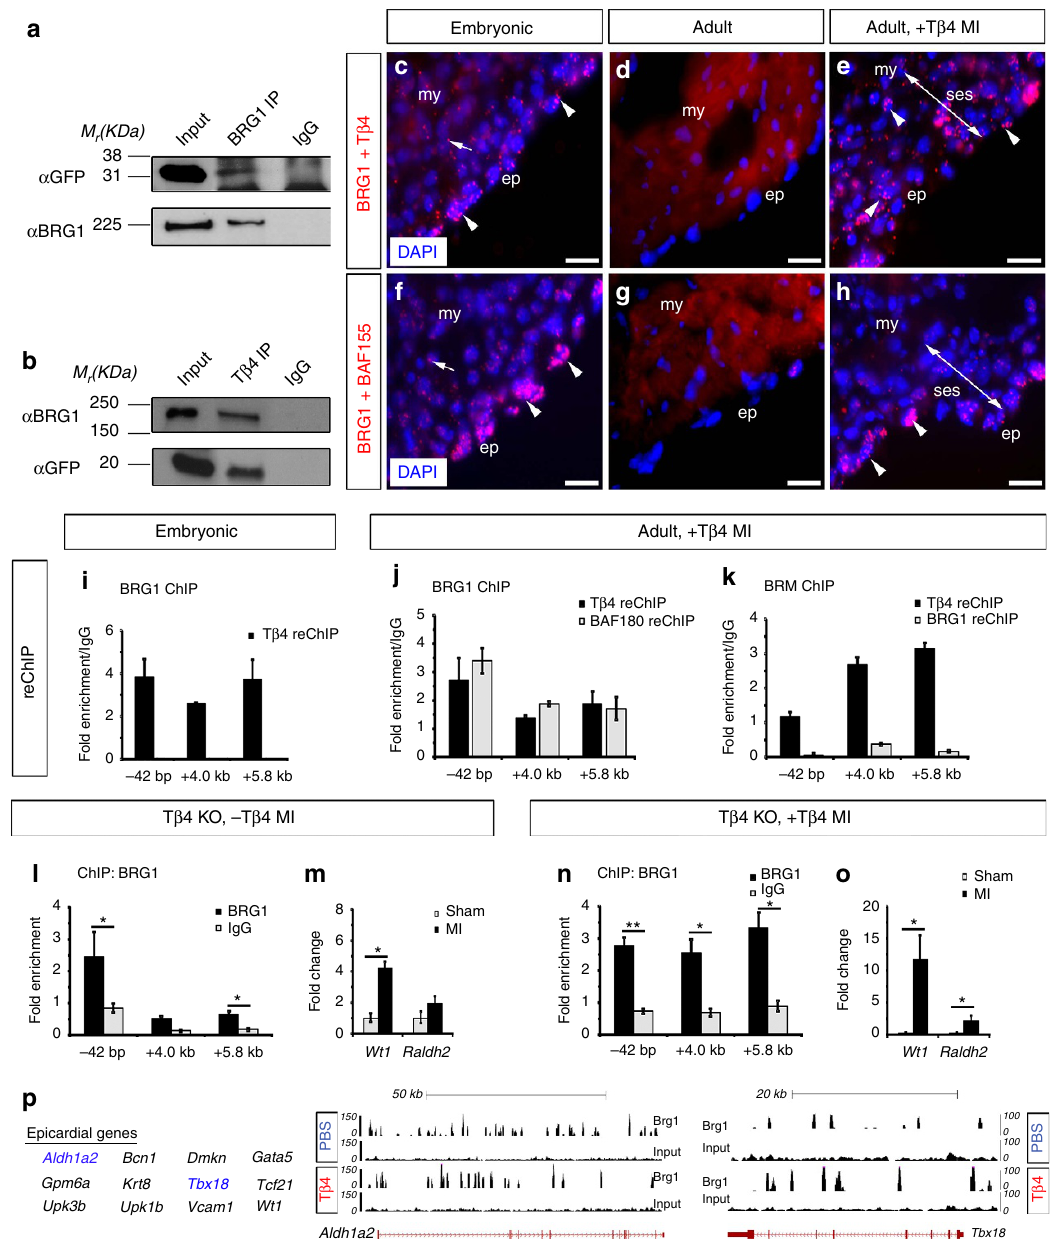
Figure 4 | T b 4 interacts with SWI/SNF enhancing activation of the adult epicardium. ( a , b ) Immunoprecipitation experiments with T b 4-EGFP- transfected cells using anti-BRG1 ( a ) or anti-T b 4 ( b ) antibodies. The original uncropped images of gels are shown in Supplementary Fig. 11. ( c – e ) Duolink in situ analysis using anti-rabbit PLUS and anti-mouse MINUS PLA probes specific for T b 4 and BRG1 antibodies respectively, in embryonic ( c ), intact adult ( d ) and post-MI hearts ( e ). ( f – h ) Duolink in situ analysis using anti-rabbit PLUS and anti-mouse MINUS PLA probes against BRG1 and BAF155. ( i – k ) re-ChIP with anti-T b 4, anti-BAF180 or anti-BRG1 antibodies using chromatin pulled-down with anti-BRG1 ( i , j ) or anti-BRM ( k ) to examine T b 4-SWI/SNF complex formation in E11.5 ( i ) and adult post-MI, primed hearts ( j , k ). ( l ) ChIP-qPCR data from chromatin derived from post-MI, T b 4 knockout (KO) adult hearts showing minimal binding of BRG1 in Wt1 ECRs. ( m ) Wt1 and Raldh2 expression analysis by qRT-PCR compared to sham-operated animals. ( n ) ChIP-qPCR data from chromatin generated from primed- ( þ T b 4), and injured- (MI) adult T b 4 knockout hearts revealing BRG1 strong enrichment in Wt1 ECRs. ( o ) Wt1 and Raldh2 expression analysis by qRT-PCR compared to sham-operated animals. At least three independent ChIP experiments per antibody per sample group ( n ¼ 10 fetal hearts; n ¼ 3 adult hearts) were performed. ChIP results are presented as fold enrichment over input, whereas re-ChIP results are present in fold enrichment over the level of ChIP with negative control IgG antibody. ( p ) List of representative BRG1-enriched epicardial genes shared between PBS- and T b 4-primed, -injured (MI) adult hearts and representative UCSC browser snapshots of the Aldh1a2 and Tbx18 loci (highlighted in blue in the list of genes) derived from the Brg1 ChIP-seq experiments. All error bars are data ± s.d. Significant differences ( P values) were calculated using two-tailed Student’s t -test (* P r 0.05; ** P r 0.01). ep, epicardium; my, myocardium; ses, subepicardial space. All scale bars 50 m m. expanded subepicardial space upon injury (arrowheads in To test the specificity of the nuclear PLA signals both a positive Fig. 4e), but not in the intact adult heart (Fig. 4d). This result was control with BRG1 and BAF155 (another subunit of the SWI/SNF in agreement with the expression pattern of BRG1 (Fig. 1a,d,g). complex, gene alias SMARCC1 , with a similar expression pattern; NATURE COMMUNICATIONS|8:16034|DOI: